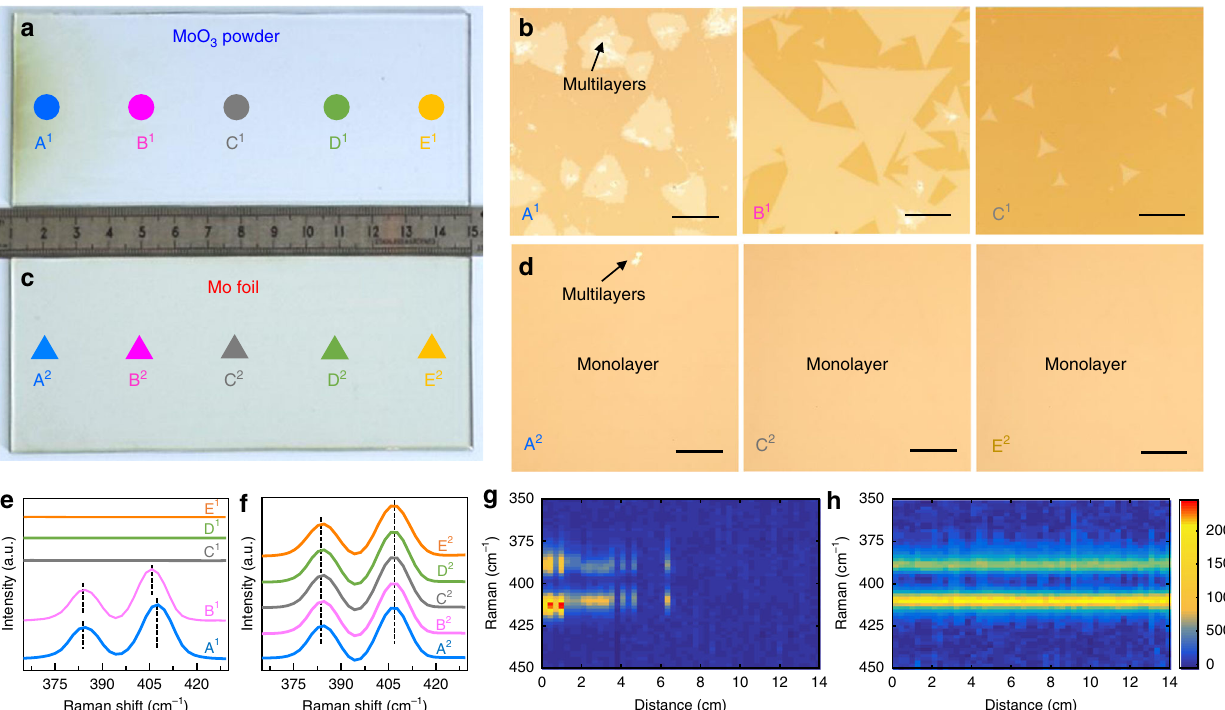
Fig. 2 Comparison of MoS 2 synthesized by a point-to-face and face-to-face metal-precursor supply routes. a , c Photographs of MoS 2 growth on 6-inch soda-lime glass using a MoO 3 powder and c Mo foil as precursors. The gas- fl ow direction was from left to right in both cases. b , d Corresponding OM images of MoS 2 synthesized using b MoO 3 powder and d Mo foil as precursors, at the points labeled A 1 , B 1 , and C 1 in a and A 2 , C 2 , and E 2 in c (with the different locations marked by colored letters; scale bars: 100 µ m). e , f Corresponding Raman spectra of MoS 2 synthesized with the MoO 3 powder and the Mo foil precursors, respectively, at the points labeled A – E in a and c . g , h Color-coded images of the typical Raman modes for the samples shown in a and c , respectively, collected from 70 positions (with an interval of 2 mm along the horizontal